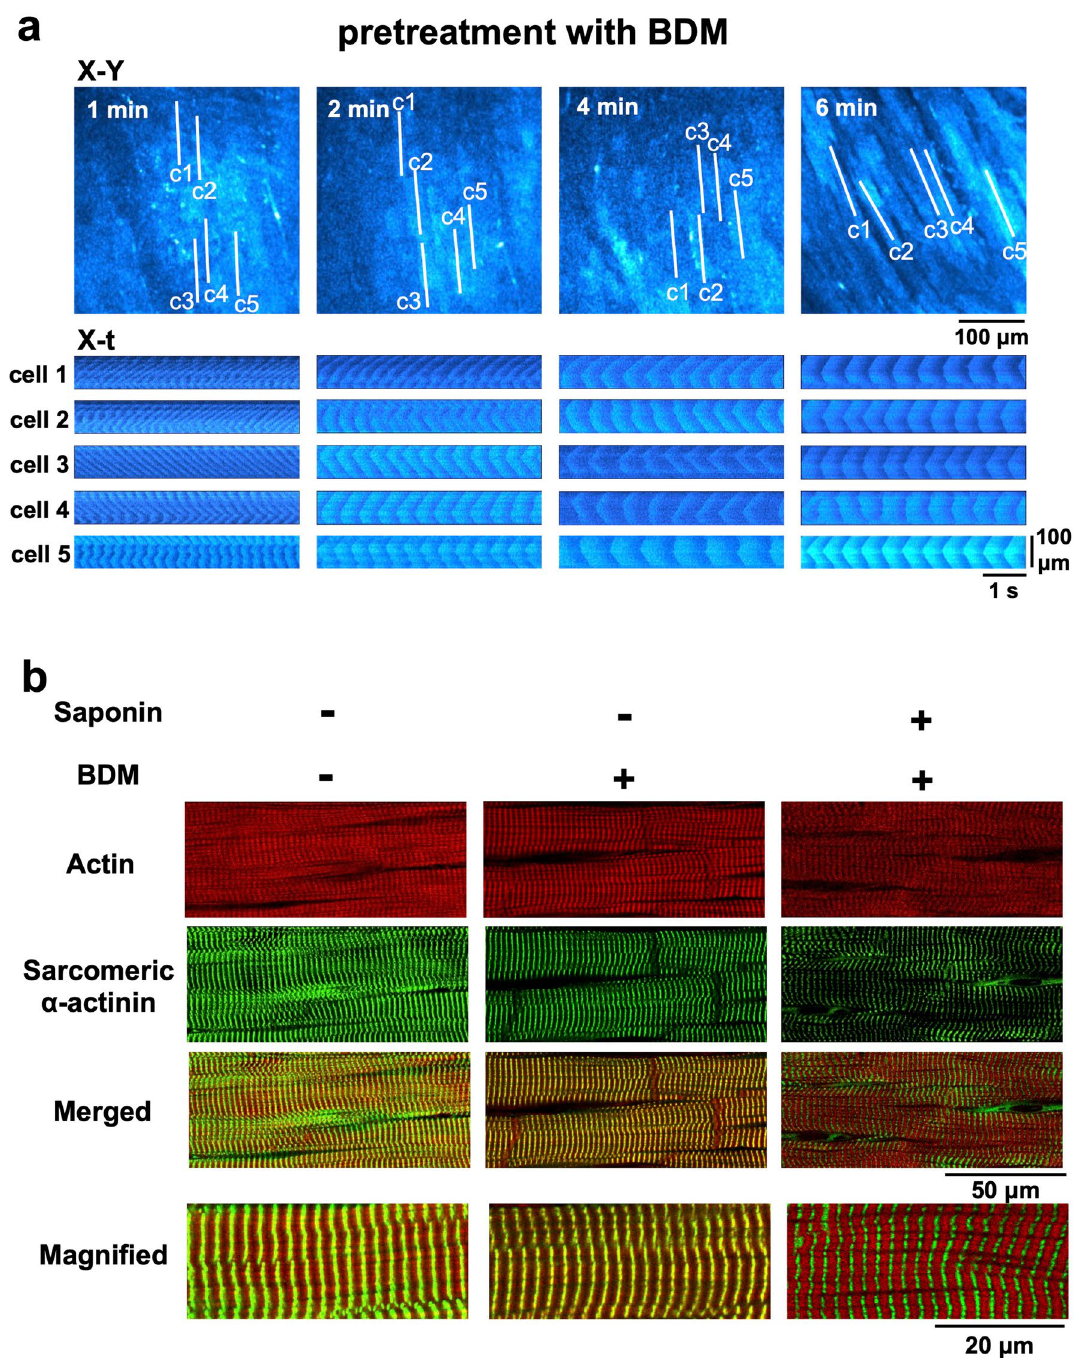
Figure 6. Prevention of saponin-induced contraction-band formation under pretreatment with 2,3-butanedione monoxime (BDM). ( a ) Sequential changes in saponin-induced Ca 2+ waves in the presence of BDM (20 mM). X–Y images (upper) and the corresponding X-t images (cells 1–5) scanned along the c1–c5 lines (100 μm) derived from the individual myocytes identified in the X–Y images. ( b ) Images include myocytes under control conditions ( left ), in the presence of 20 mM BDM ( middle ), and under saponin treatment in the presence of BDM ( right